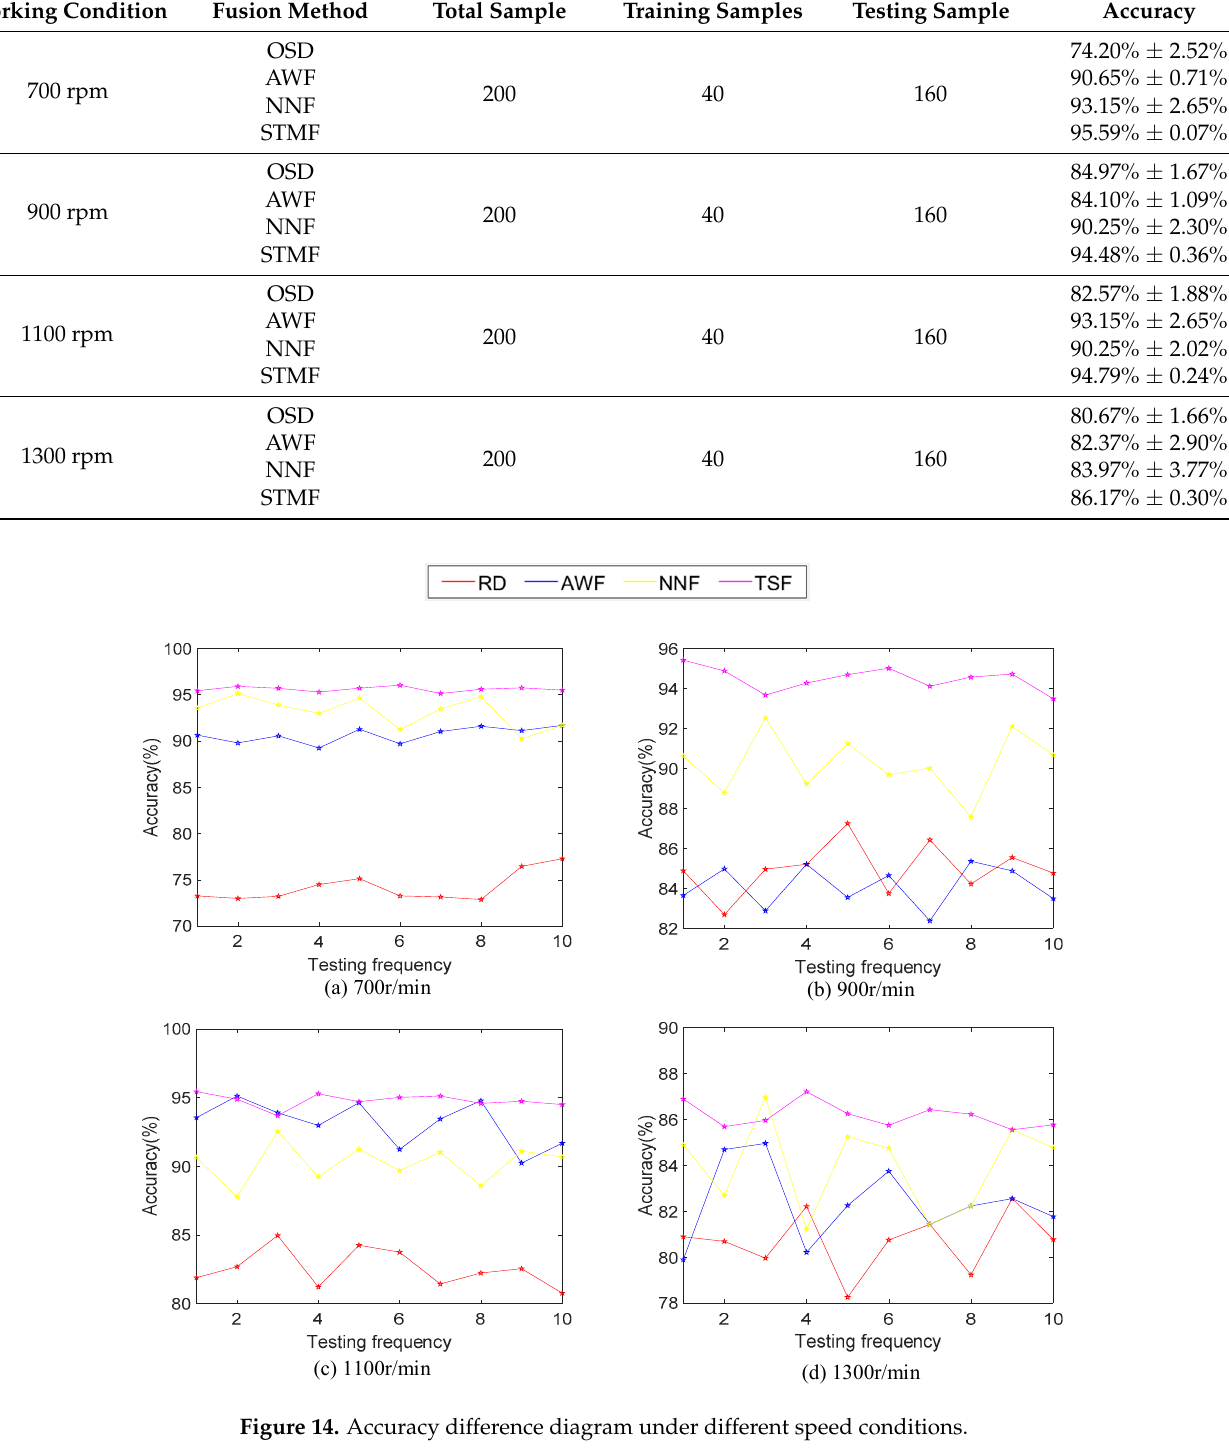
Table 4. SAE handles the fault classification accuracy rate of different data.